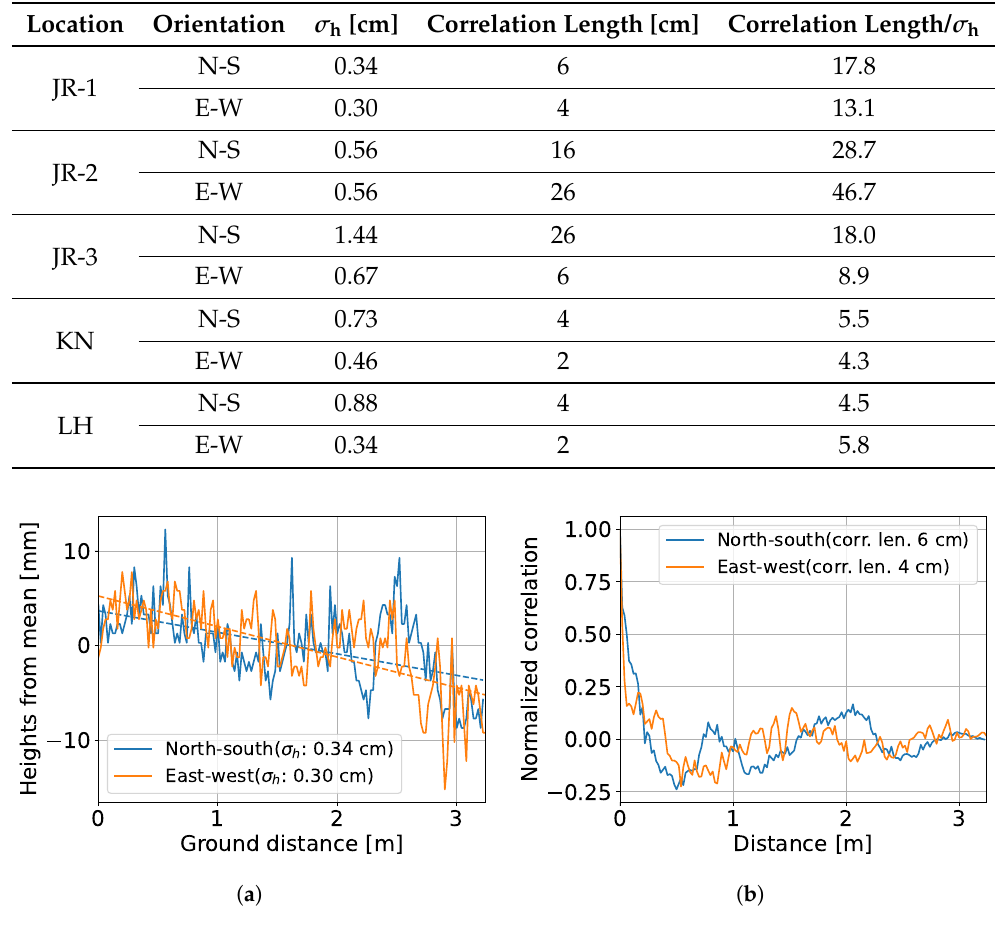
Figure 5. JR-1 roughness measurements: ( a ) Surface height measurements; ( b ) Surface